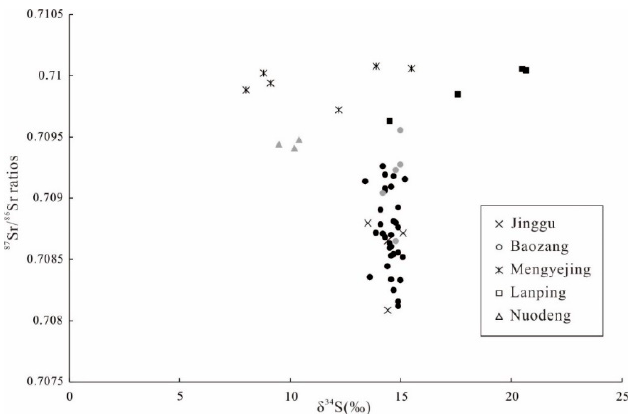
Figure 10. Sr-S isotopic compositions of evaporites in the Lanping–Simao Basin. The dark black symbols indicate layered gypsum samples, whereas grey symbols indicate veined gypsum samples.